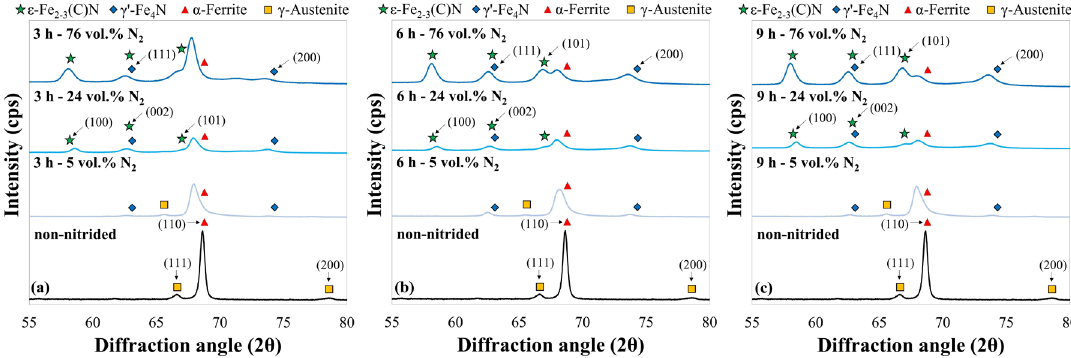
Figure 2. (a) Optical microstructure of cross-section of plasma nitrided samples for 9 h with gas mixture composition of 24 vol.% N (b) Diffusion zone and compound layer of plasma nitrided samples.